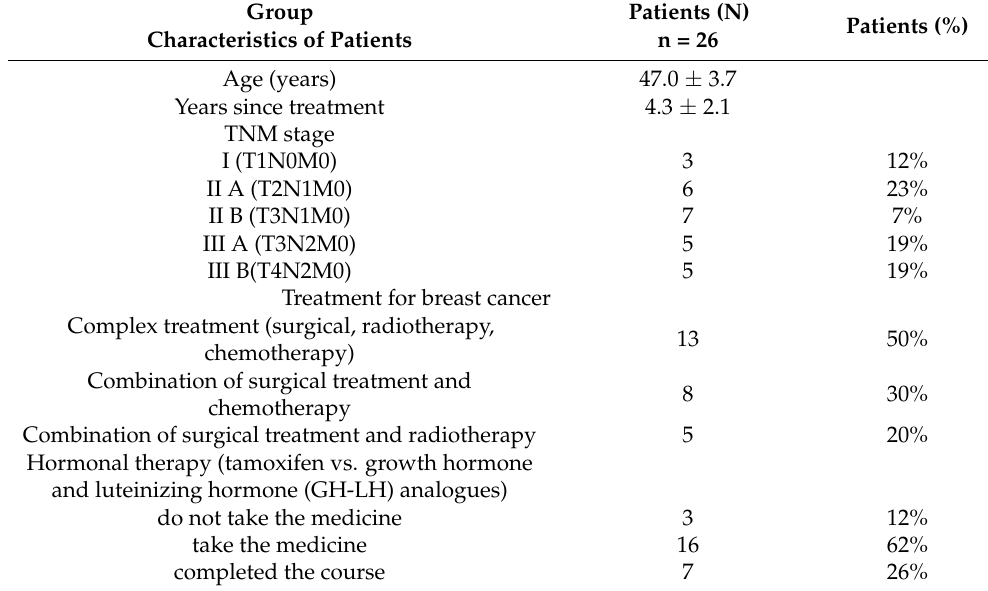
Table 1. Characteristics of the patients presented after breast cancer (BC) treatment. Group Characteristics of